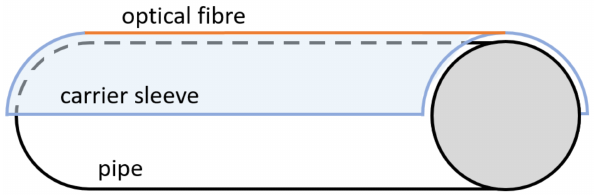
Figure 6. Schematic diagram of an FBG sleeve sensor described in